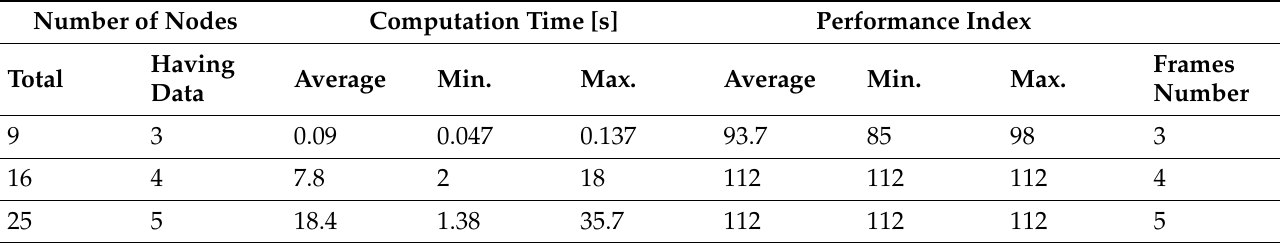
Table 4. Results for algorithm using maximal energy consumption index.